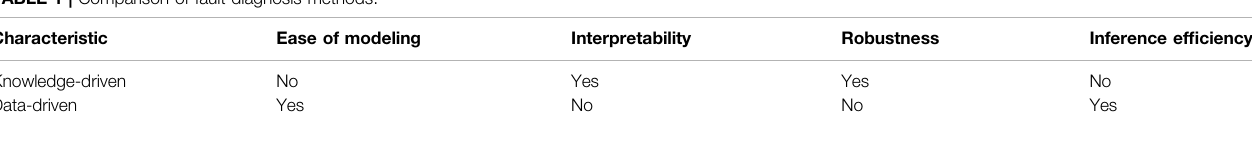
TABLE 1 | Comparison of fault diagnosis